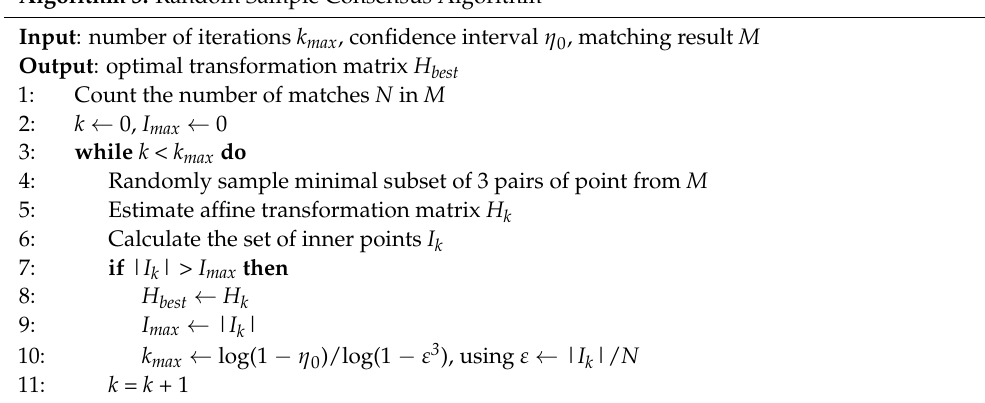
Algorithm 3: Random Sample Consensus